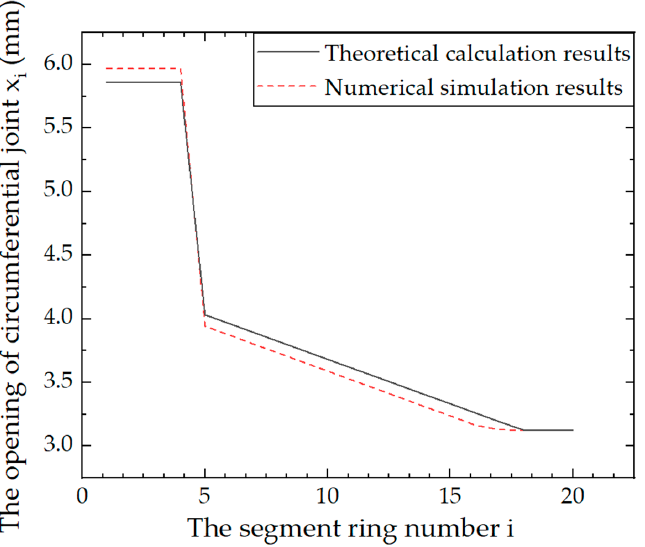
Figure 11. The comparison diagram of theoretical calculations and numerical simulation under the basic case.